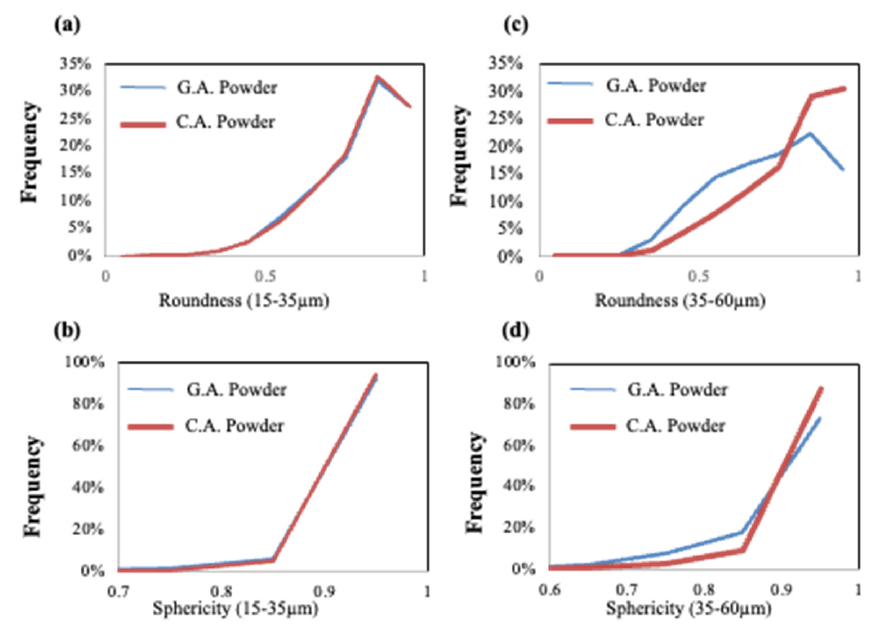
Figure 5. Roundness and sphericity distributions of the particles analyzed between 15–35 μ m ( a , b ) and 35–60 μ m ( c , d ).